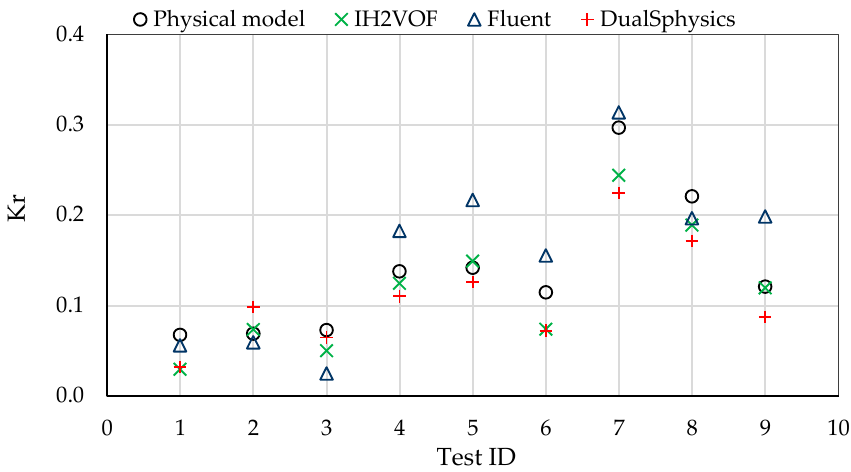
Figure 14. Reflection coefficient obtained for all cases with h = 0.50, 0.58, and 0.62 m. Maximum wave run-up and mean wave overtopping discharge obtained in the physical model are compared with those obtained by the numerical model for the nine cases, shown in Tables 12 and 13, for a time interval corresponding to 25 wave period for analysis.